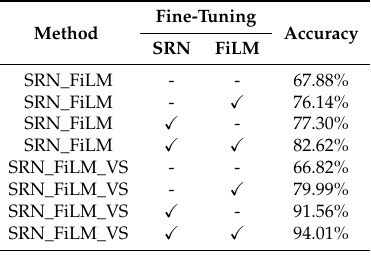
Table 5. Evaluation results for Multi-view-CLEVR_4views_ Real